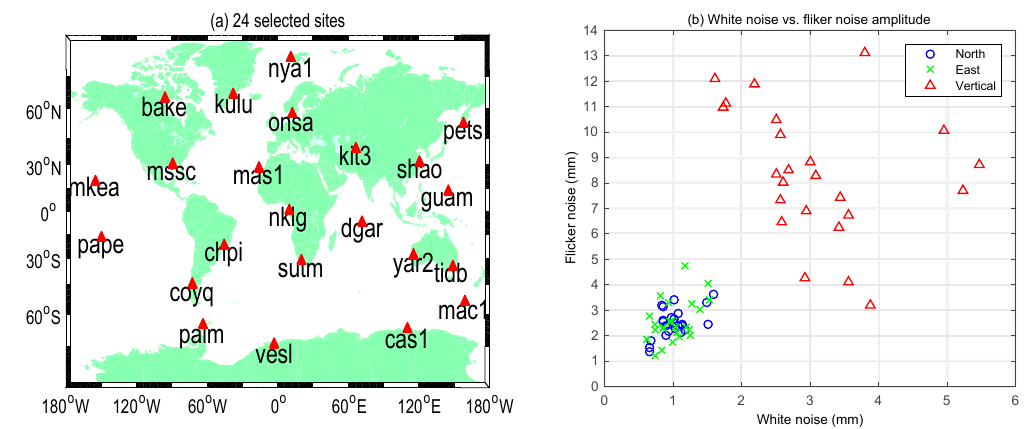
Figure 2. ( a ) The 24 global even distribution sites to show the noise characteristics of GPS time series; ( b ) White noise components and flicker noise components corresponding to 24 selected GPS sites.